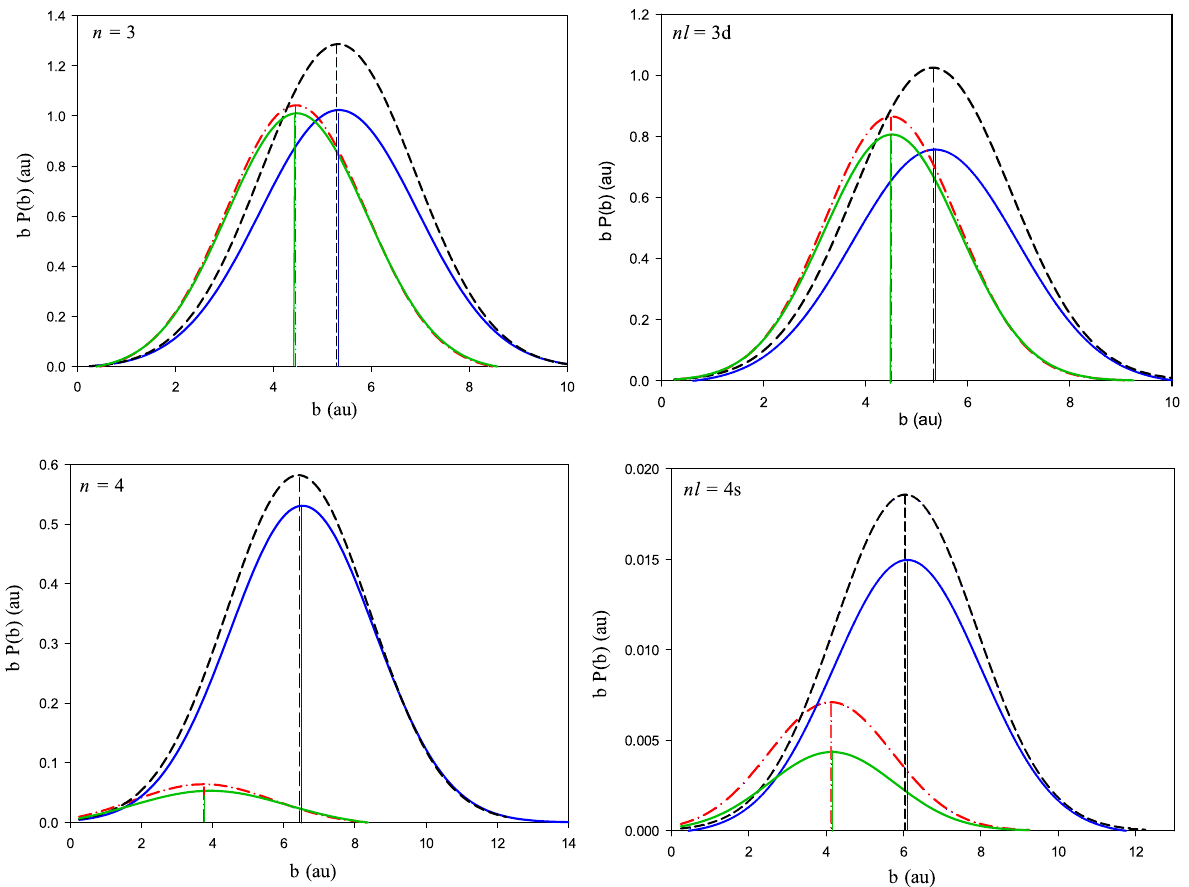
Figure 2. Probability for electron capture into n = 3, 4 and nl = 3d, 4 s states of the projectile (multiplied by impact parameter) in Be 4+ + H(1 s ), as a function of the impact parameter, at 10 keV/amu impact energy. Dash- dotted red line: present CTMC results, dash black line: present target-centered QCTMC results, solid green line: present projectile-centered QCTMC results, solid blue line: combination of